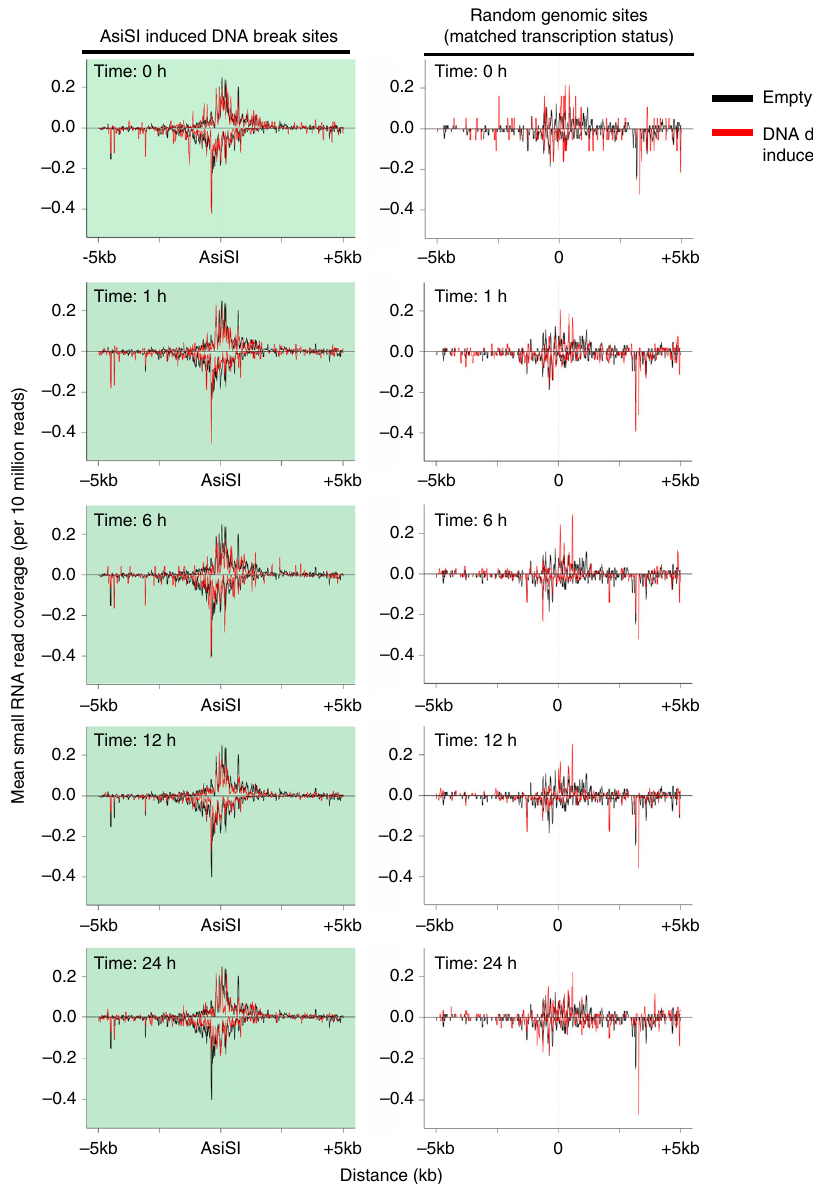
Fig. 6 No signi fi cant enrichment of small RNA is found around 99 known AsiSI cut sites in the genome. Coverage pro fi les of 21 – 23 nt non-miRNA small RNAs that map to regions 5 kb on either side of AsiSI cut sites at different time points after induction of damage. Negative coverage refers to those reads mapping to the consensus genome minus strand. Left, 99 cut AsiSI sites (shaded with pale green). Right, same number of random genomic sites with similar transcriptional activity to the 99 AsiSI cut sites, as determined by TPM count and gene length from 4sU-Seq data on control cells (analysis described in Methods). These graphs are centred around a point (denoted as 0) at the same distance from the TSS as the matched AsiSI site. Each time point in the AsiSI transfected samples (red lines) is superimposed on reads from the EV control (black lines). As the EV control has never been exposed to the speci fi c cuts produced by AsiSI, there is no potential for any small RNAs produced by that event to be present. Any reads present in the EV control can therefore be considered proteins have a role in the formation of DNA:RNA hybrids after investigate the formation of R-loops on a genome-wide scale and DNA damage induction. To directly investigate the formation of determine if Drosha plays a role in this process, we conducted DNA:RNA hybrids around break sites we utilized the S9.6 next generation paired-end sequencing of the DRIP genomic antibody, which speci fi cally recognises DNA:RNA duplexes, for fragments (DRIP-Seq) 41 . We con fi rmed that DNA:RNA hybrids accumulate in the promoter and termination regions of genes in a DNA:RNA-immunoprecipitation (DRIP) 40 in the inducible AsiSI endonuclease system. Remarkably, qPCR analysis of the hybrid- transcriptional activity-dependent manner, as seen previously containing immunoprecipitated genomic fragments revealed a (Supplementary Fig. 14C) 42 . Consistent with our qPCR data, we signi fi cant enrichment of these structures at damage sites that observe a striking increase of DNA:RNA hybrid reads mapping to undergo repair by HR as well as NHEJ (Fig. 7b) 7 . This is speci fi c the proximity of AsiSI cut sites for break sites resolved by both HR and NHEJ 7 , but not for uncut genomic loci (Fig. 7c). A sharp to DSB sites because the level of R-loops at a highly transcribed decrease of reads at the nucleotides corresponding directly to the locus ( γ -actin ) remains unchanged after damage induction. To